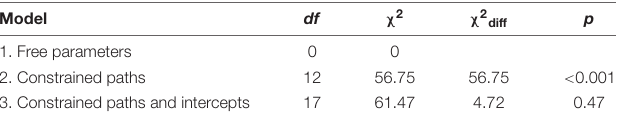
TABLE 2 | Descriptive statistics for study variables by parent gender.